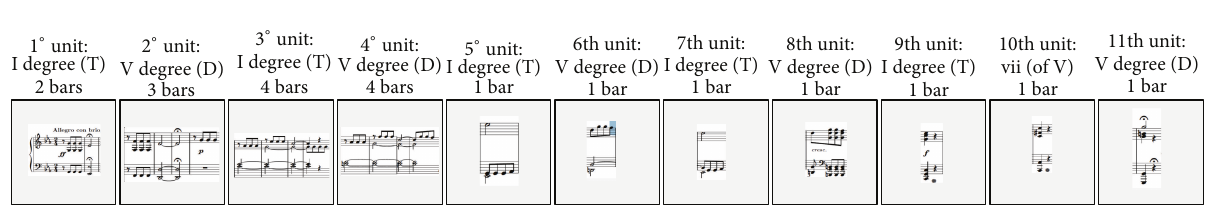
Figure 5: A geometric interpretation of the first 21 bars of Beethoven’s Symphony Number 5 segmented in 11 units corresponding to the harmonic changes.